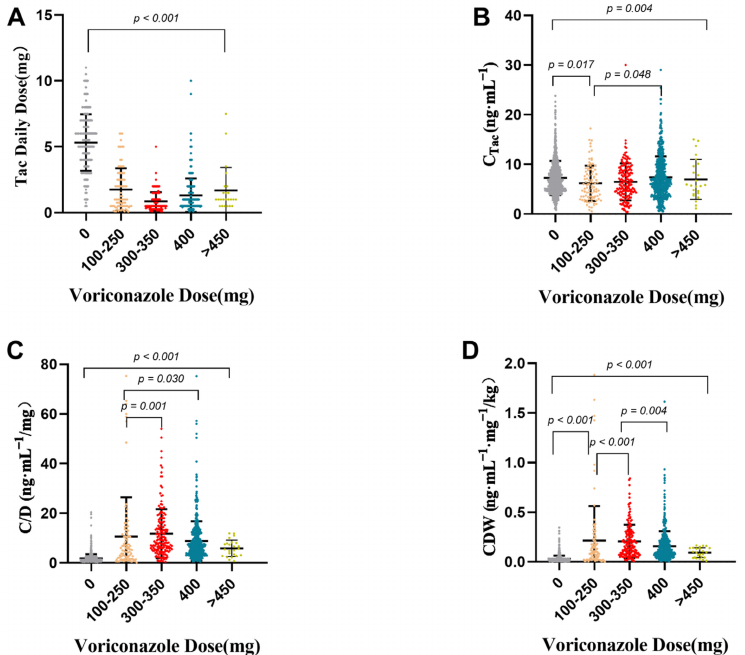
Figure 2. Effects of voriconazole dose on tacrolimus daily dose ( A ), C Tac ( B ), C/D ( C ), and CDW ( D ). p value was tested by Kruskal–Wallis test and adjusted by Dunn–Bonferroni correction; direct concentration (C Tac ), standard concentration adjusted by tacrolimus daily dose (C/D), and weight- adjusted standard concentration (CDW).